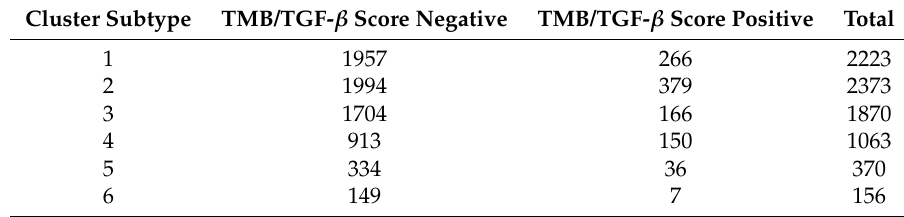
Table A2. Distribution of TMB/TGF- β score positive and negative cases in each Cluster subtype as described by Thorsson et al. [17] modify